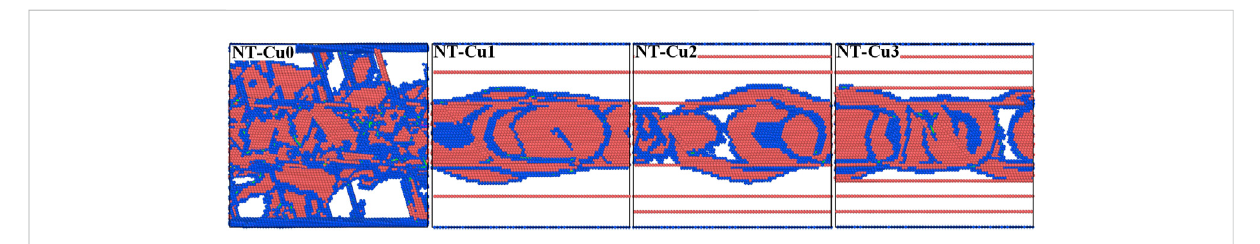
FIGURE 3 At10.14%tensiletruestrain,picturesofdislocationsforHNTandGNTsamples(FCCatomsarehiddenforaclearrepresentationofdislocations).